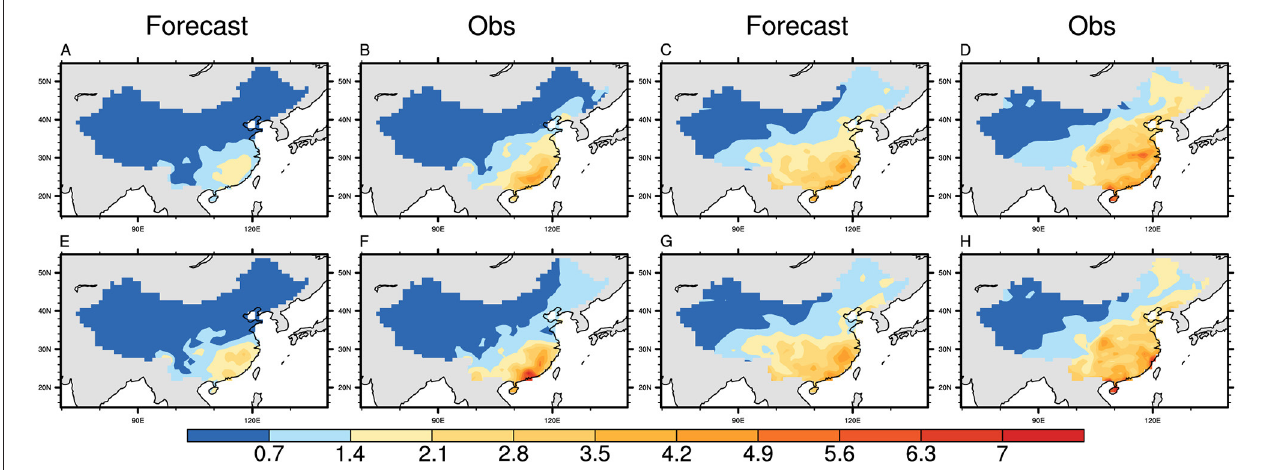
FIGURE 4 | Standard deviation of MultiLLR model predicted and observed precipitation (mm/day) of Win-Spr (A,B,E,F) and Sum-Aut season (C,D,G,H) in the high-skill years (up panels) and low-skill years (low panels), the first and third columns represent the forecast, and the second and fourth columns represent the observation values.